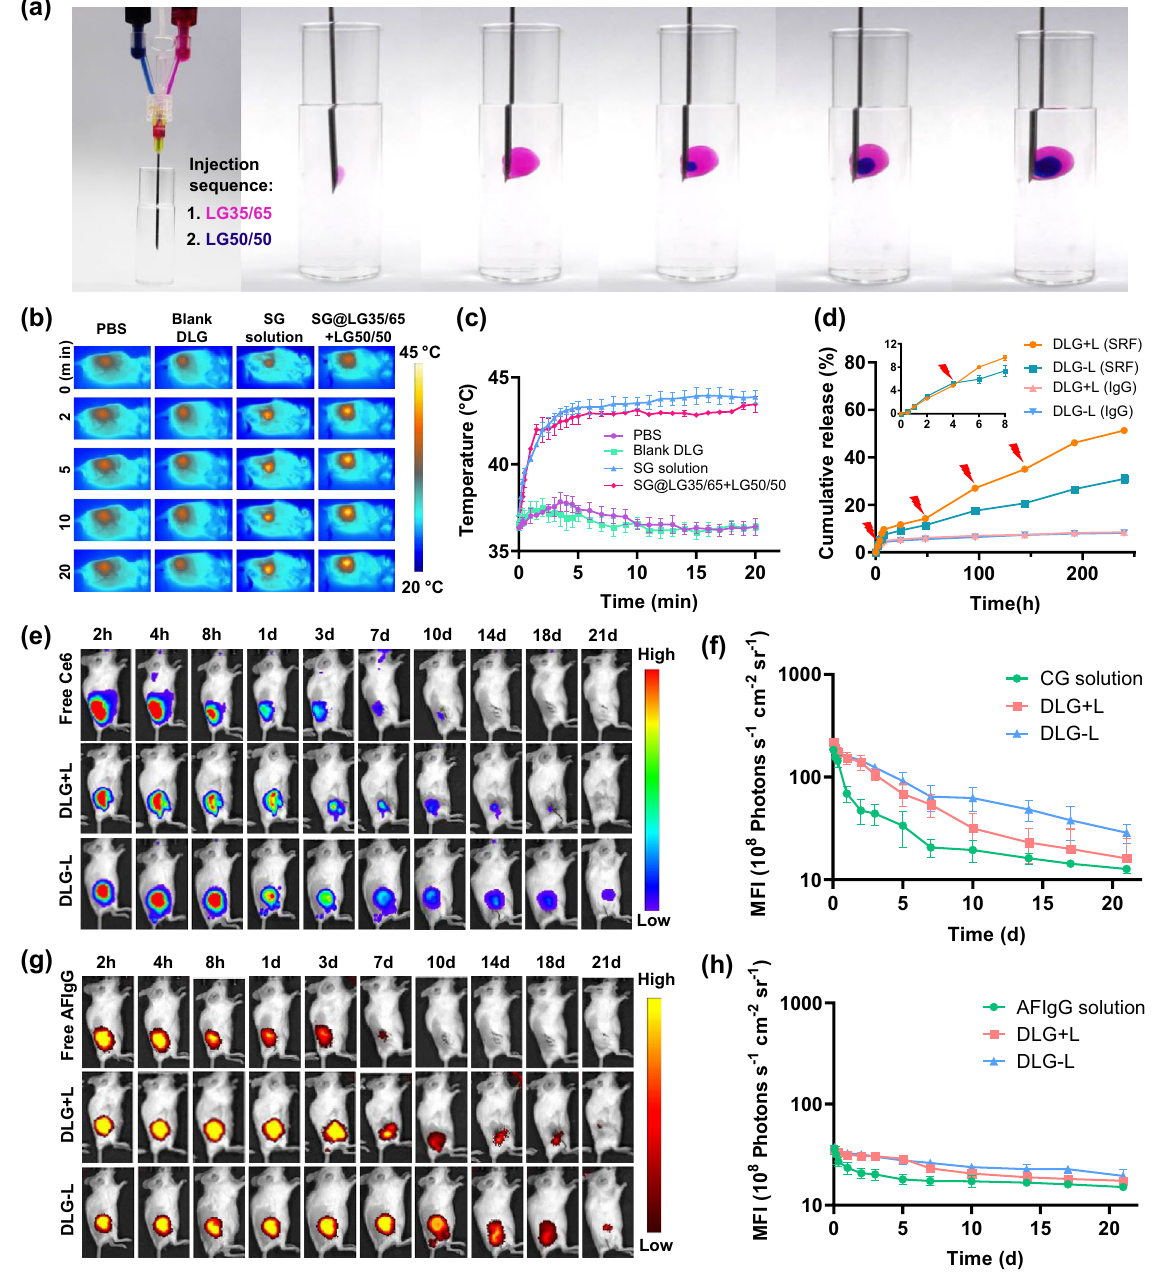
Fig. 2 Characterization of the DLG matrix. a The formation of a DLG matrix using the dual syringe kit. The outer layer LG35/65 was loaded with Rose Bengal and the inner layer LG50/50 was loaded with Methylene Blue for better illustration. b In vivo infrared thermal images of the tumor sur- gical sites in 4T1-bearing mice irradiated immediately after being treated with PBS, blank DLG, Free SG solution, and LG50/50 + SG@LG35/65. Images were recorded at 0 min, 2 min, 5 min, 10 min, and 20 min after 808 nm laser irradiation. c Manually controlled temperature increase in the tumor resection sites on 4T1 tumor-bearing mice, where different formulations were injected, by tuning the NIR laser irradiation for 10 min. d The photothermal controlled cumulative release profiles of sorafenib and the long-term sustained cumulative release profiles of IgG from the DLG matrix. Data are shown as means ± SEM ( n = 3). e Fluorescence IVIS images depicting the in vivo retention of Ce6 fluorescence in mice injected with Ce6 solution (Free Ce6), and DLG matrix (CG@lg35/65 + AFIgG@LG50/50) with (DLG + L) or without (DLG-L) the NIR irradiation. f Mean fluores- cence intensity (MFI) of corresponding fluorescence IVIS images in ( e ). g Fluorescence IVIS images depicting the in vivo retention of AFIgG fluores- cence in mice injected with AFIgG solution (Free AFIgG), and DLG matrix (CG@lg35/65 + AFIgG@LG50/50) with (DLG + L) or without (DLG-L) the NIR irradiation. H) MFI of corresponding fluorescence IVIS images in (G). Data are shown as means ± SEM ( n = 3). NIR laser: 808